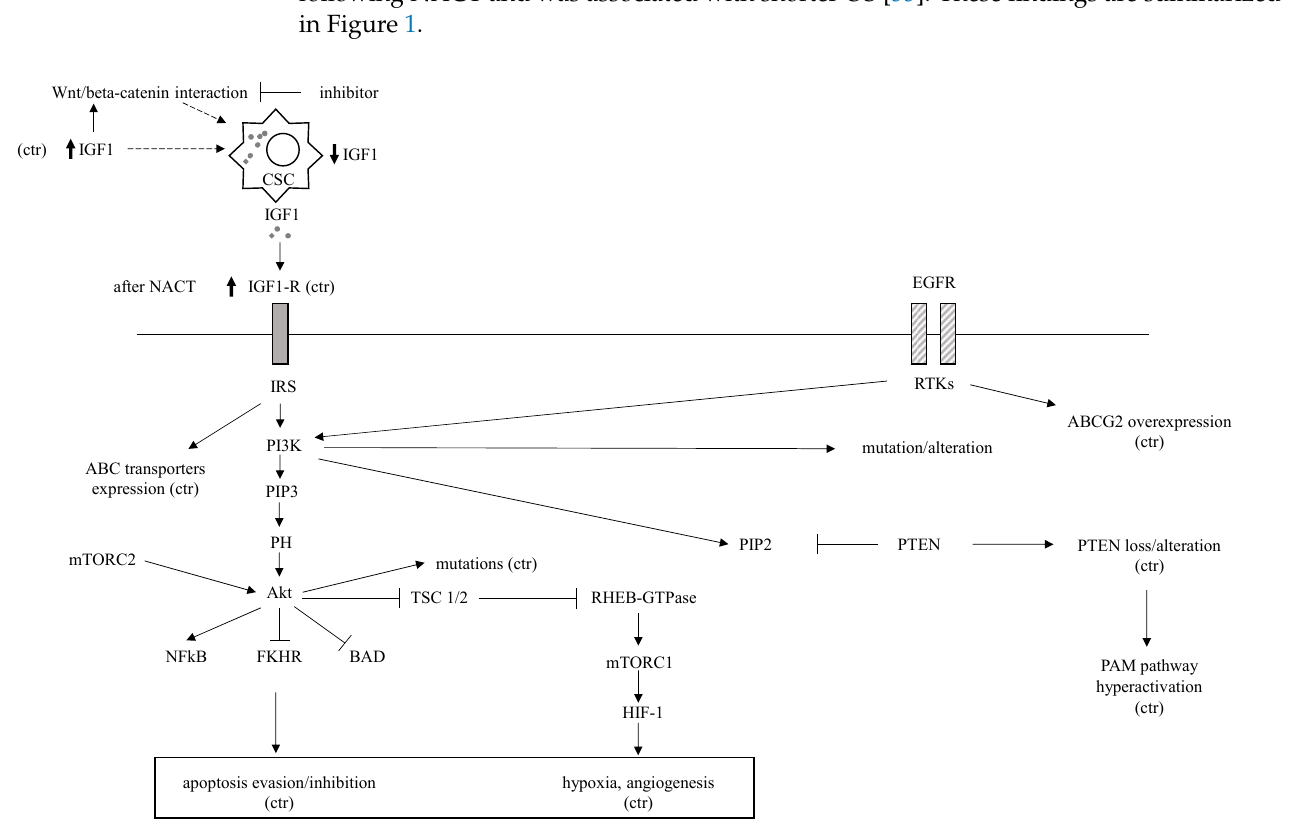
Figure 1. EGFR, IGF1-R, and PI3K-Akt-mTOR (PAM) pathway. Potential mechanisms of chemo- therapy resistance (ctr) in TNBC. PI3K activation produces PIP3 from PIP2 substrate; Akt activation inhibits TSC, which acts as a GTPase activating protein for RHEB; mTORC1 induces hypoxia and angiogenesis via modulation of HIF-1; mTORC2 promotes apoptosis evasion/inhibition through NFkB, FKHR, and BAD; PTEN and TSC are significant tumor suppressors. IGF1: insulin growth factor 1; IGF1-R: insulin growth factor 1 receptor; CSC: cancer stem cell; NACT: neoadjuvant chemotherapy; EGFR: epidermal growth factor receptor; RTKs: receptors with protein tyrosine kinase activity; PIP2: phosphatidylinositol-4,5 biphosphate; PIP3: phosphatidylinositol-3,4,5 triphosphate; PH: protein with pleckstrin homology; Akt: protein kinase B; GTPase: guanosine triphosphatase; HIF-1: hypoxia inducible factor 1; IRS: insulin receptor substrate; mTORC1/2: mammalian target of rapamycin complex 1/2; PI3K: phosphatidylinositol 3 kinase; PTEN: phosphatase and tensin homolog deleted on chromosome 10; TSC: tuberous sclerosis; RHEB: RAS homolog enriched in brain (GTP-binding protein); FKHR: forkhead family transcriptor factors; ABC: ATP binding cassette; ABCG2: ATP bind- ing cassette superfamily G member 2; NFkB: nuclear factor kappa-high chain enhancer of activated B cells; BAD: Bcl-2 associated death promoter. ↑ increase; ↓ decrease. Also see